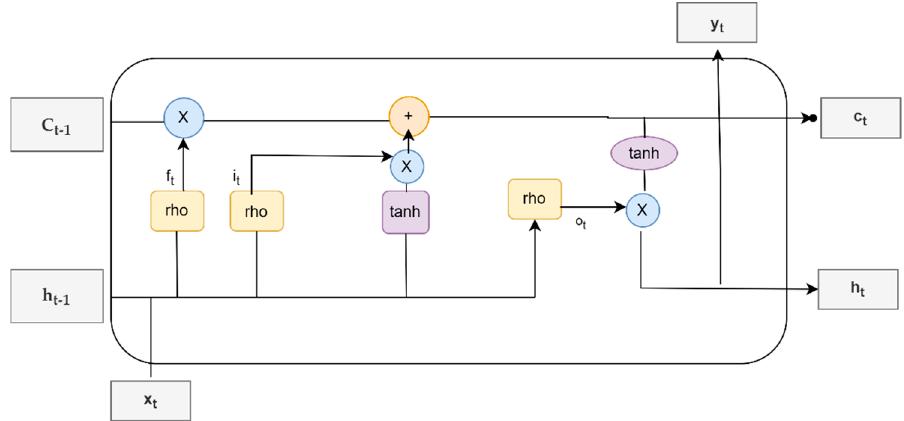
Figure 2. The structure of the LSTM model at time